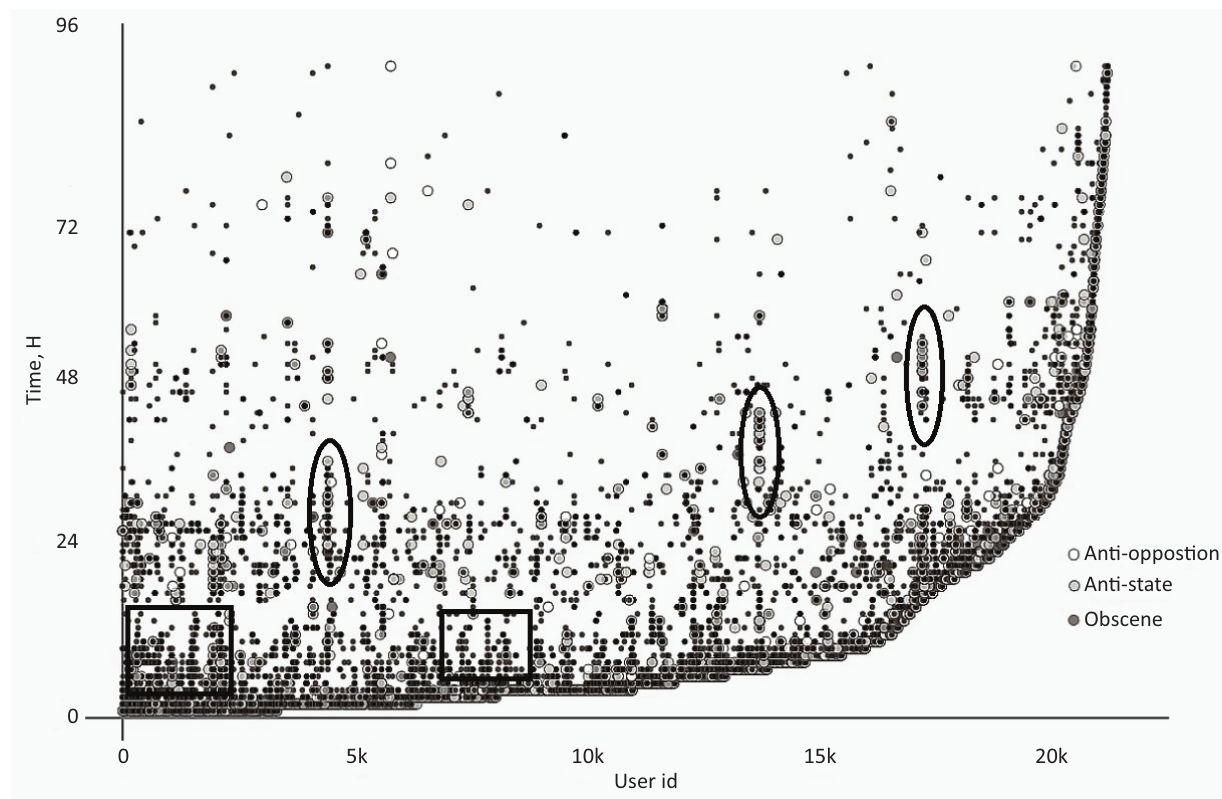
Figure 3. Interval histogram of the discussion, video 1: Individual aggressive vs. interactive neutral speech. Media and Communication, 2021, Volume 9, Issue 1, Pages